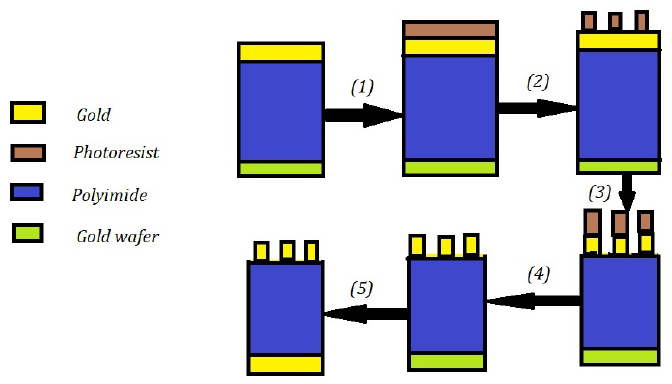
Figure 8. Absorption spectra as a function of polarization angle.